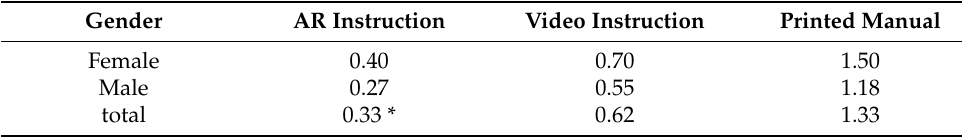
Table 4. Number of errors per participant during performing the